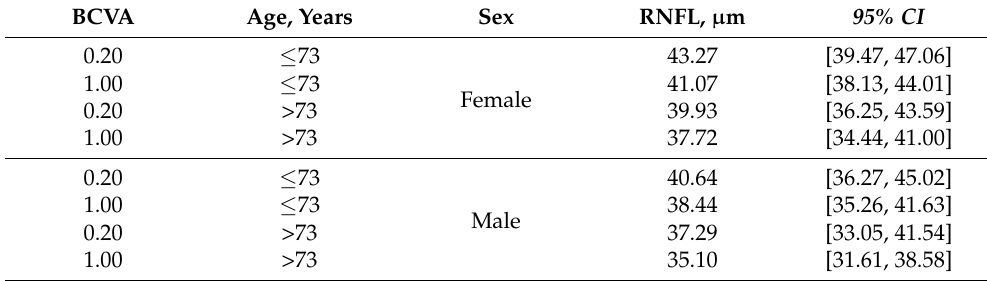
Table 4. Predictions for RNFL thickness based on BCVA lower and upper sample size range {0.2, 1.0} within age and sex